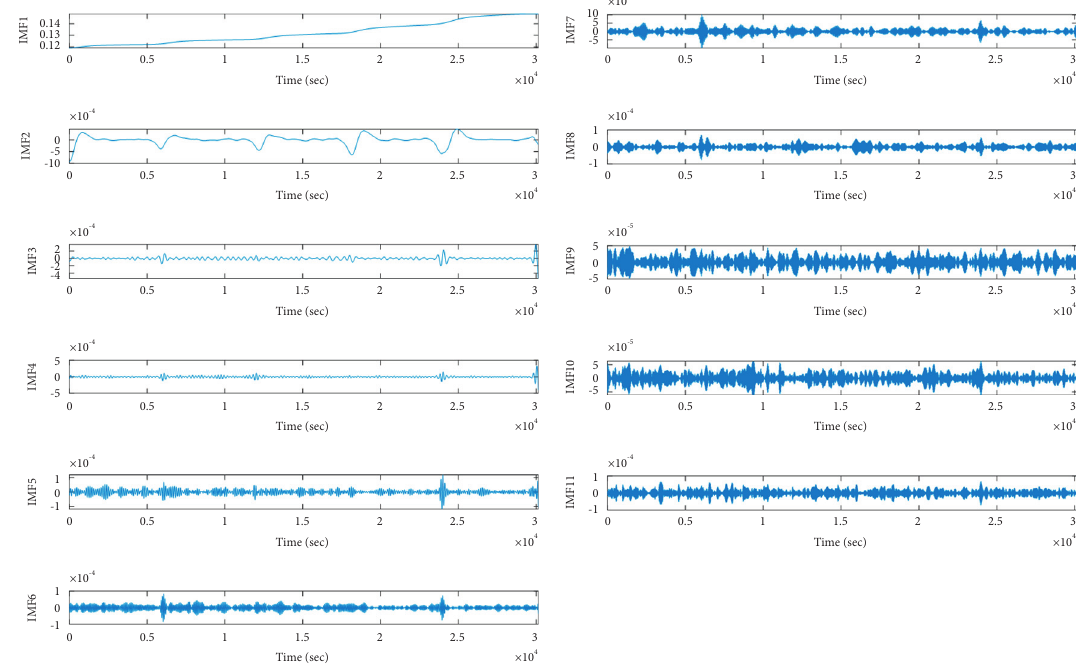
Figure 10: Signal after